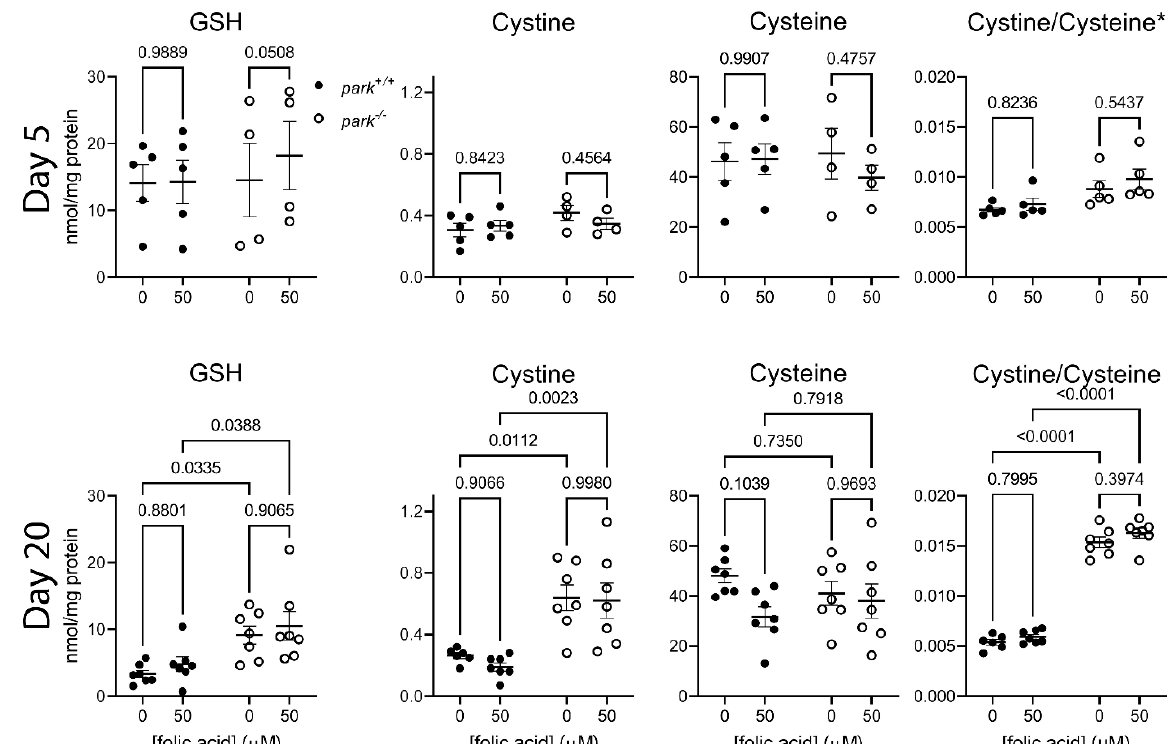
Figure 7. Folic acid administration does not affect oxidative stress marker elevation in parkin-null fly heads. Heads of folic acid-treated park +/+ and park −/− flies were collected and frozen on days 5 (top row) and 20 (bottom row) post eclosion. LC-MS/MS was performed to detect reduced glutathione (GSH), cystine, and cysteine. The increased ratio of cystine to cysteine in parkin-null flies indicates oxidative stress, which is unaffected by folic acid administration. Each data point represents one tube of lysate or the average of up to three lysate tubes collected on the same day. Each tube contained seven to thirty-four heads. Effects of genotype and folic acid were determined using two-way repeated measures ANOVA followed by Šídák’s multiple comparison test (day 5) or two-way ANOVA followed by Tukey’s multiple comparisons test (day 20). Graph title asterisk indicates significant effect of genotype ( p < 0.05). p values for post hoc comparisons are shown ( n = 5 for day 5 and 7 for day 20).